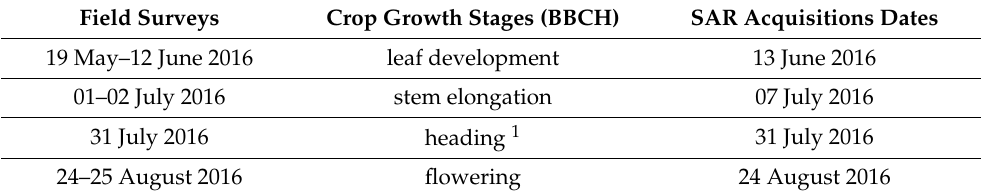
Table 1. Biologische Bundesanstalt, Bundessortenamt, and CHemische (BBCH) ‐ identification keys for field measurements and Synthetic Aperture Radar (SAR) data acquisitions of the study area.